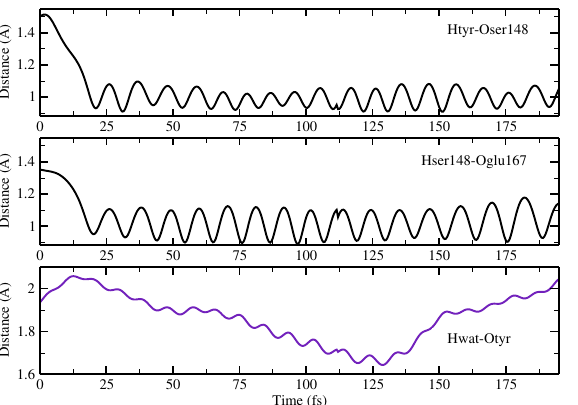
Figure 16. Time evolution of the donor OH distances (Å) involved in concerted PT. Upper panel: evolution of the OH(tyr) distance. Lower panel: evolution of the OH(ser) distance.